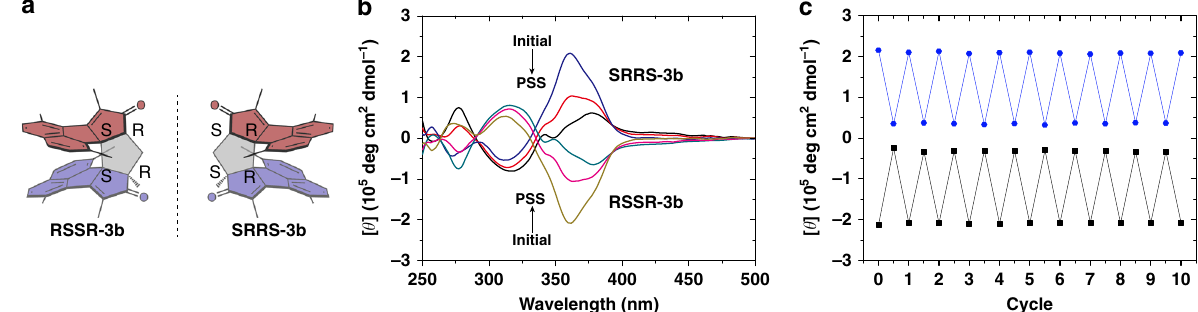
Fig. 7 Chiral photoswitching of 3b . a Enantiomers of 3b . b CD spectra of RSSR- 3b and SRRS- 3b upon UV irradiation at 365 nm. c Molar ellipticity at 360 nm upon UV irradiation at 365 nm for 70 s and then heated at 55 °C for 45 min in repeated cycles (SRRS- 3b in blue line and RSSR- 3b in black